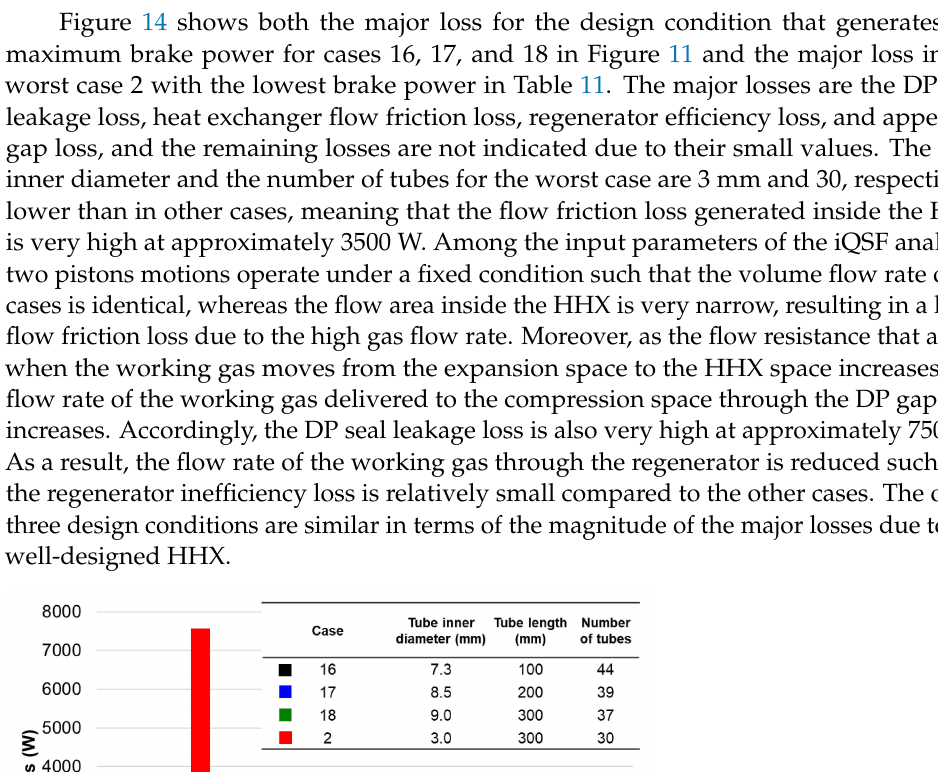
Figure 13. Portion of the total loss for the optimal HHX design conditions in the optimal case 19 (inner tube diameter 8.5 mm, tube length 220 mm, number of tubes 39).